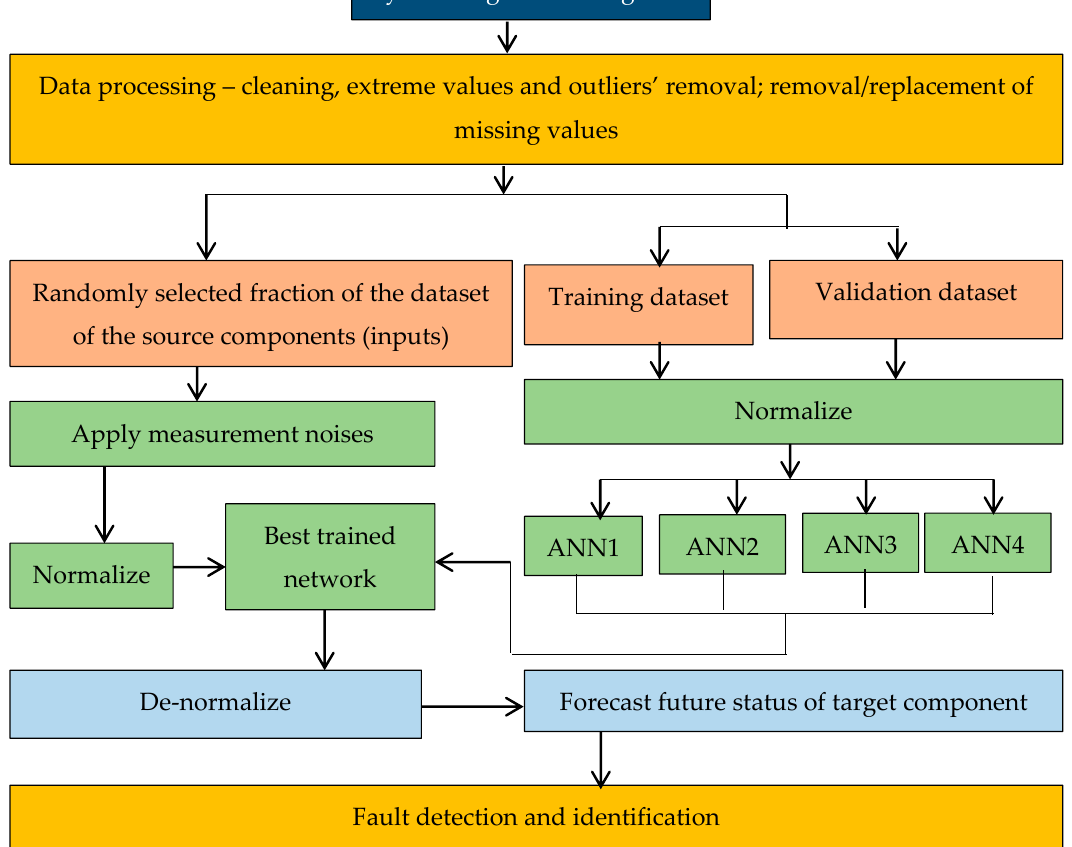
Figure 2. Integrated process of fault detection and identification with Artificial Neural Networks (ANNs).